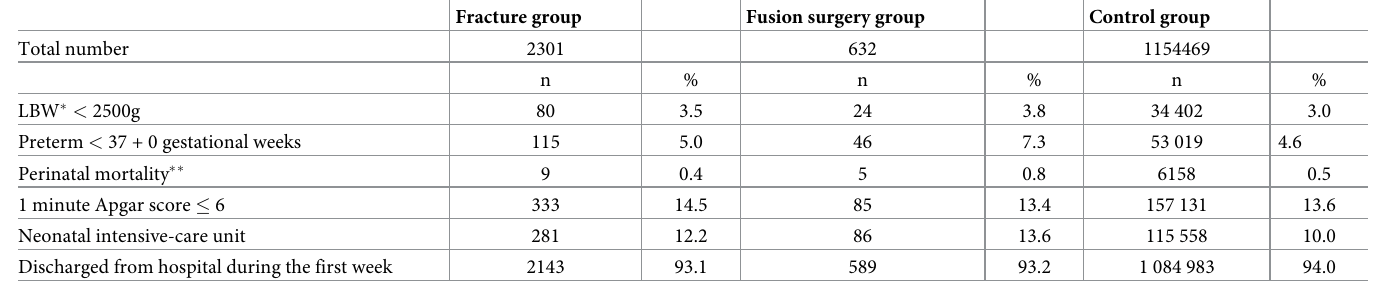
Table 4. Perinatal characteristics and outcomes in the patient groups and the control